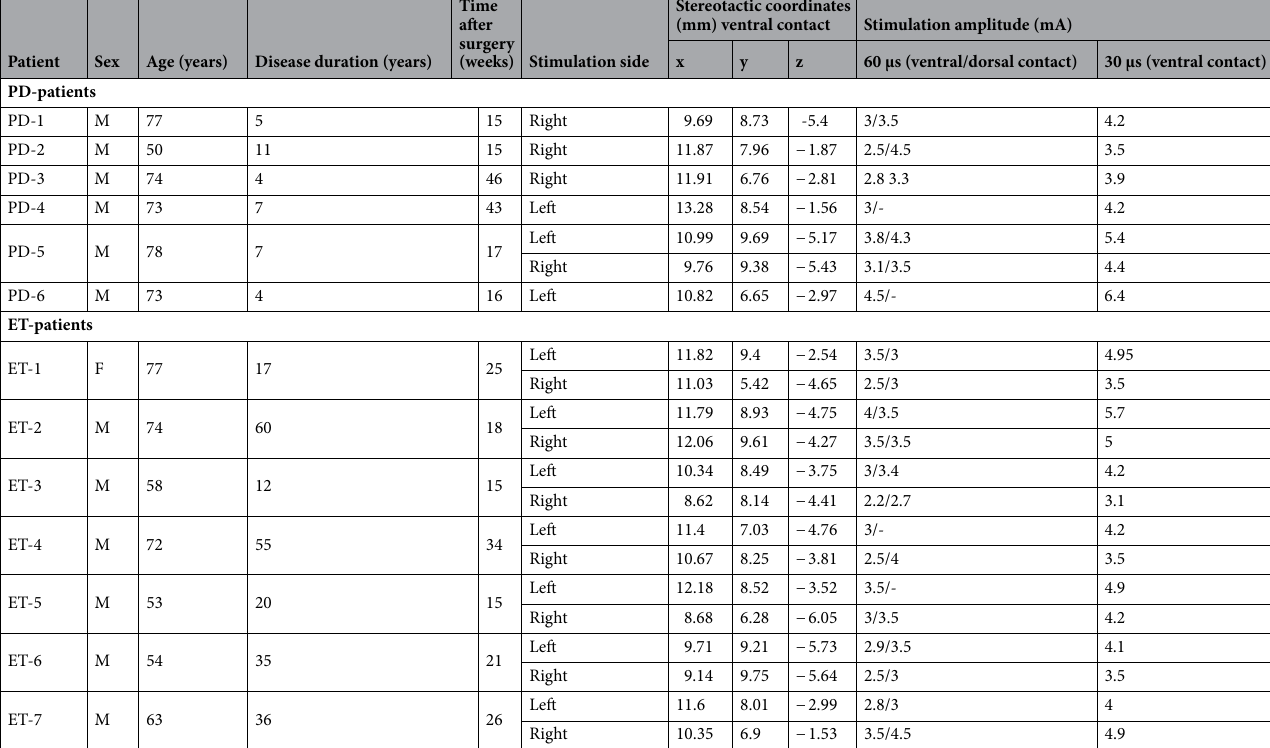
Table 1. Demographic data and stimulation parameters of Parkinsonian (PD) and Essential Tremor (ET) patients. “Disease duration” (years) is calculated from symptom onset to the study assessment. “Time after surgery” (weeks) is calculated from the date of surgery to the study assessment. “Stimulation side” is the hemisphere side of the electrode. “Stereotactic coordinates” are the coordinates of the lowest “ventral” and 2nd lowest “dorsal” contacts with x = lateral to midline, y = posterior to mid-commissural point (MCP), z = above the plane between anterior and posterior